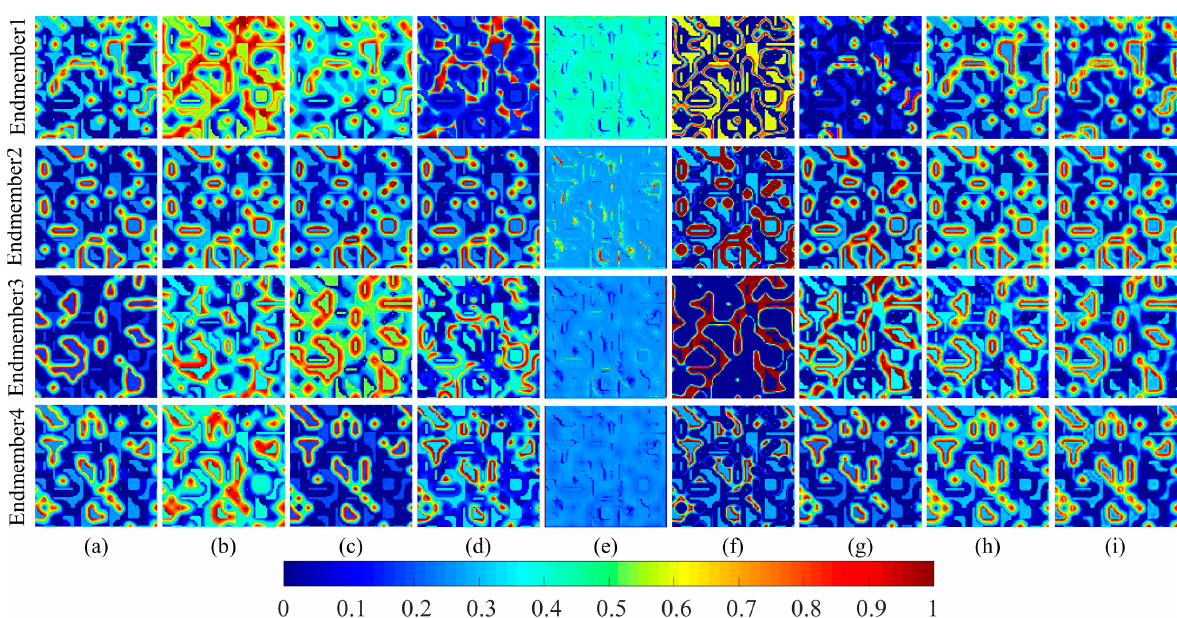
Figure 9. Visualization results of the abundances of the synthetic data (SNR 40 dB). ( a ) VCA-FCLS. ( b ) SGCNMF. ( c ) DAEU. ( d ) MTAEU. ( e ) CNNAEU. ( f ) CyCU-Net. ( g ) MiSiCNet. ( h ) SSANet. ( i ) Ground truth (GT).